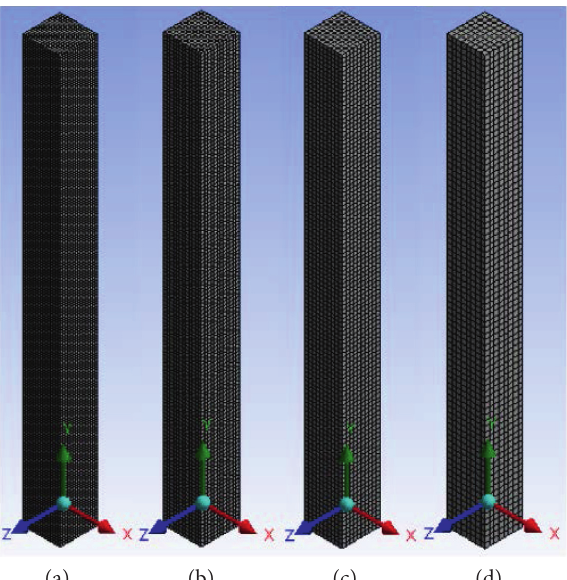
Figure 4: AUTODYN FEA model for CONV_20 RC column with different mesh sizes: (a) 20mm; (b) 25mm; (c) 30mm; (d)